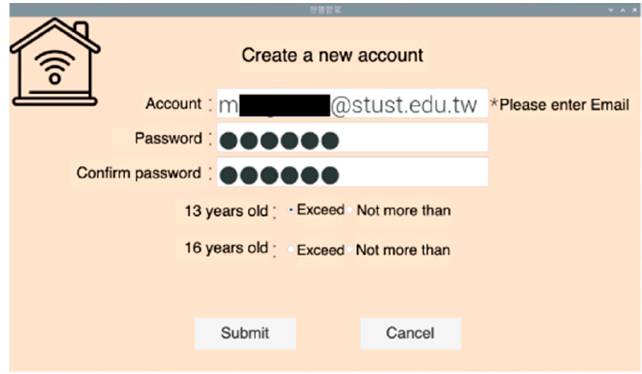
Figure 10. Interface of account creation age over 13.